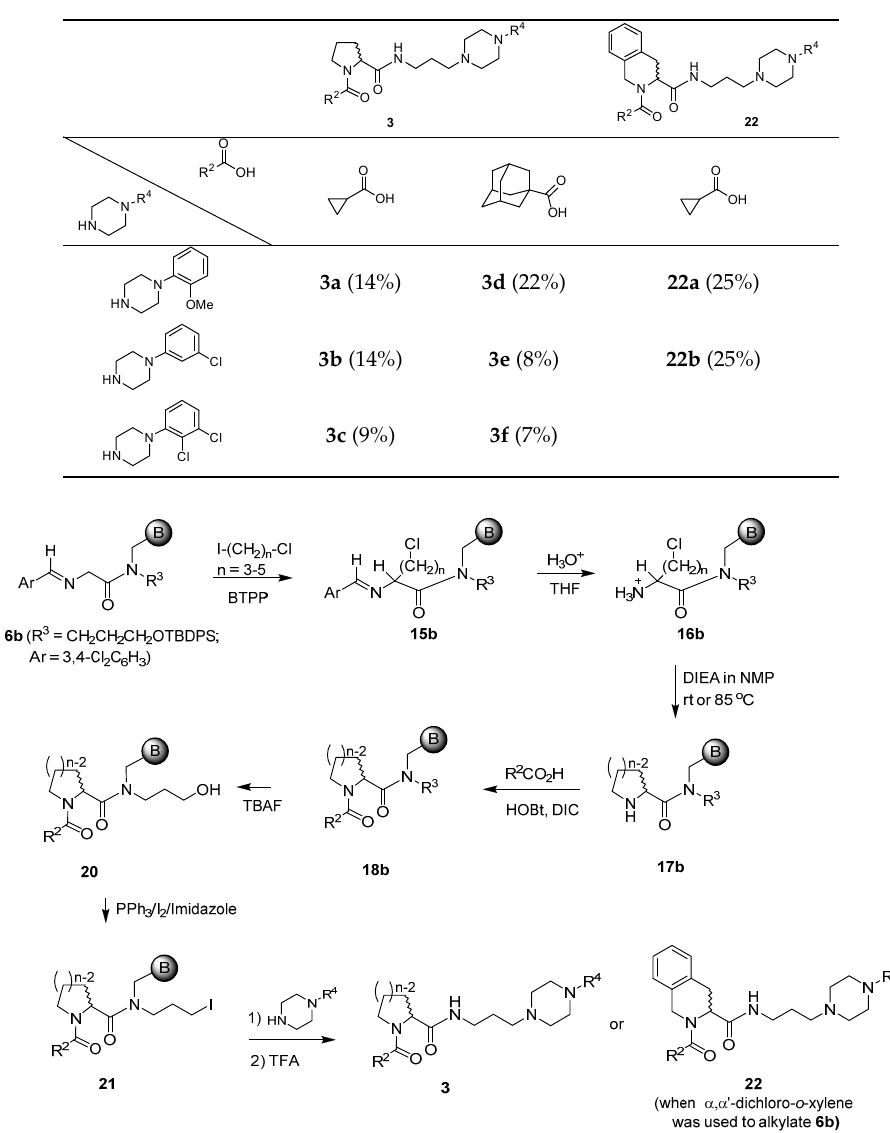
Table 2. Survey of eight cyclic amino acid amide compounds successfully prepared from two alkylating agents, two carboxylic acids, and three piperazines.